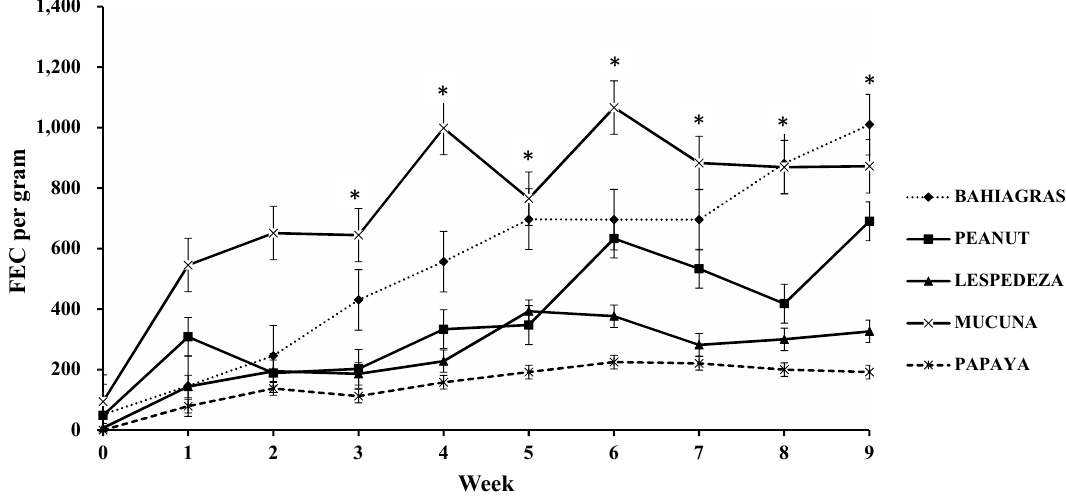
Figure 1. Effects of supplementing bahiagrass (BG) hay with perennial peanut (PEA), lespedeza (LES) hay, mucuna (MUC), or papaya seeds (PAP) on gastrointestinal fecal egg counts (FEC). Treatment×time, p<0.05. Error bars are standard errors. * Counts at the week specified differed (p<0.05).